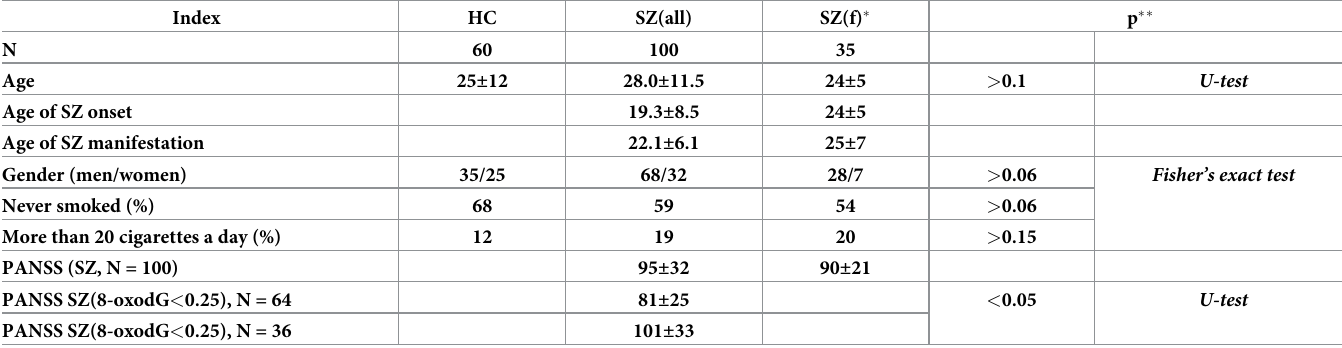
Table 1. Demographic and clinical measures in the SZ and HC